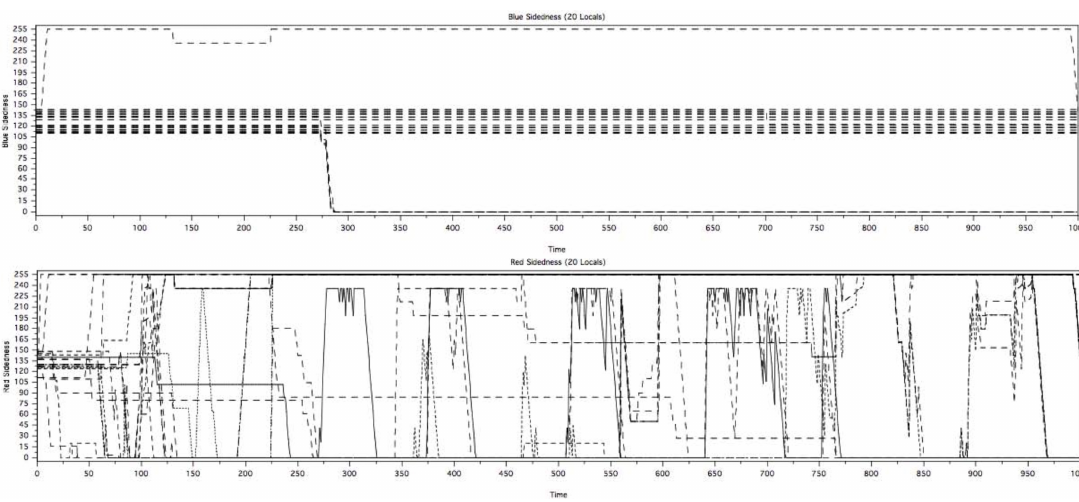
Figure 3. Time series of color change in the clique Scenario.